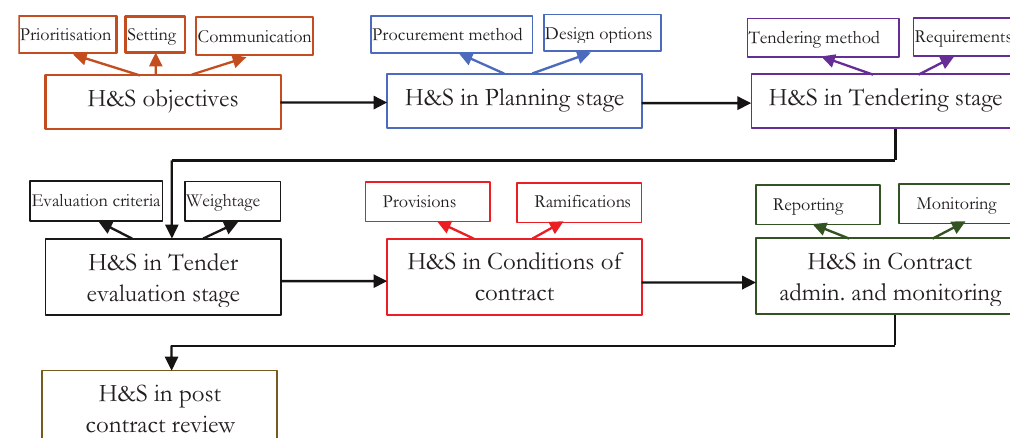
Figure 2. Thematic map showing themes and related